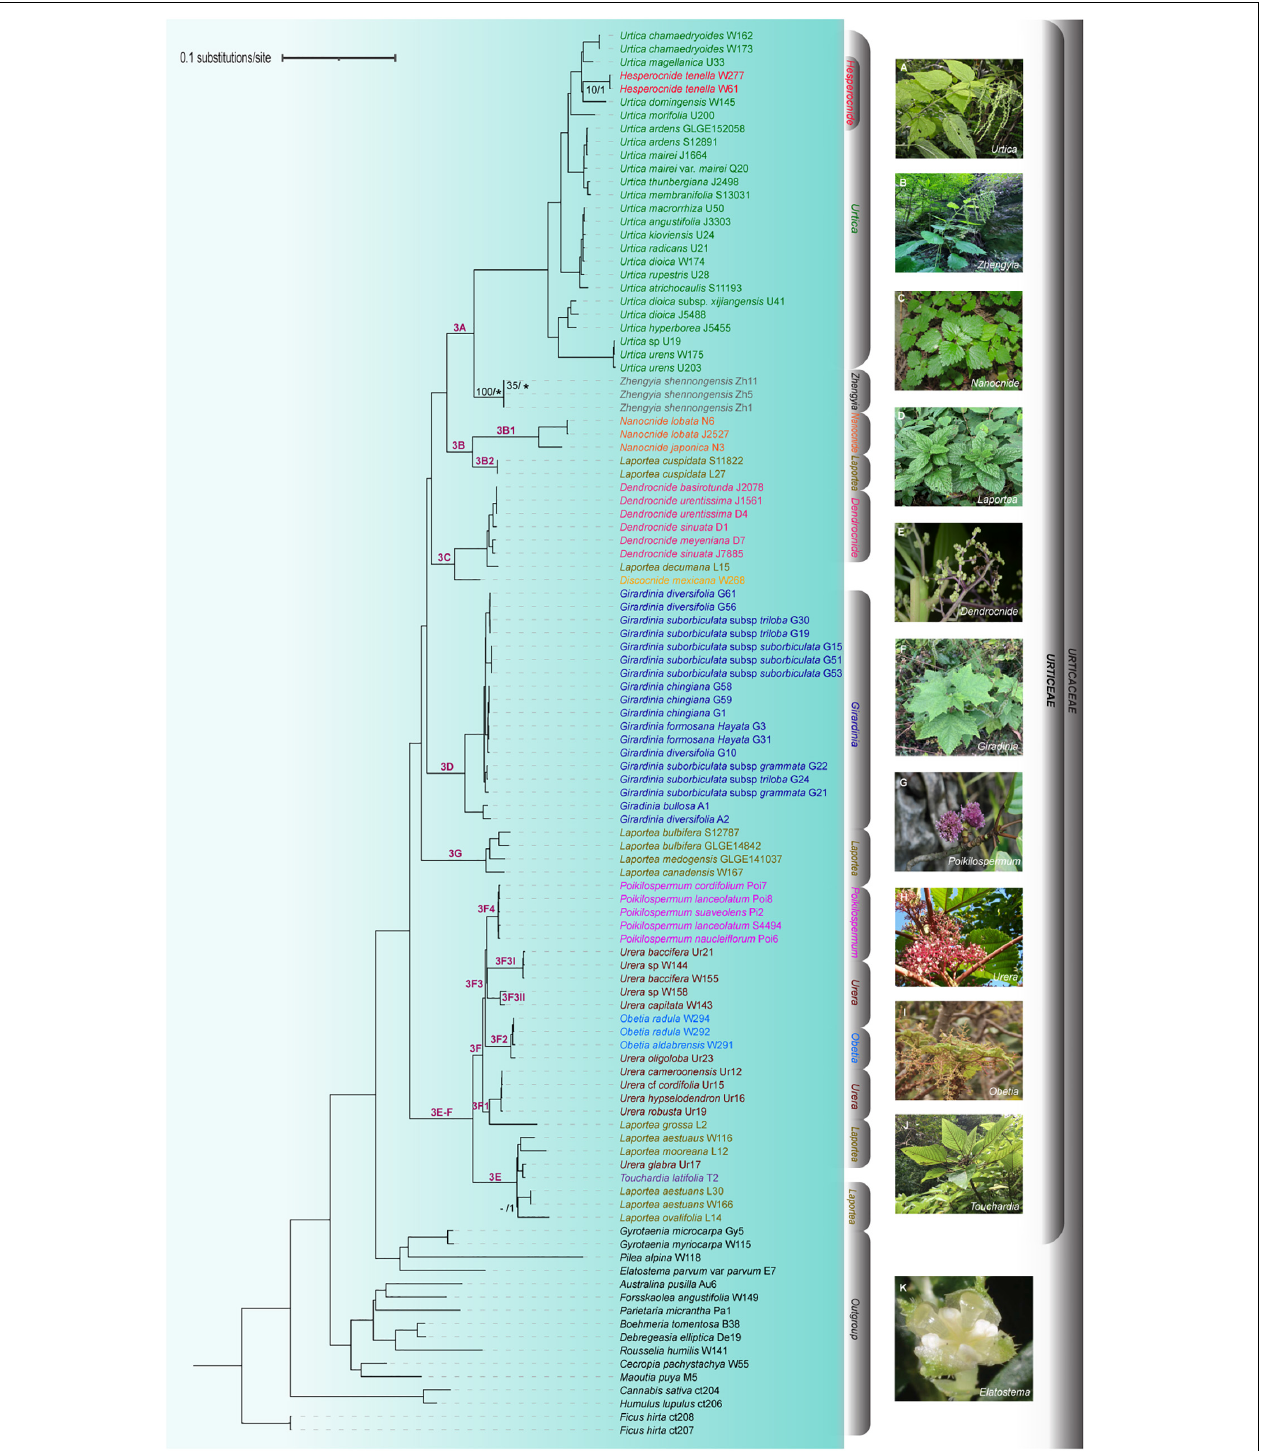
FIGURE 5 | Phylogenetic relationships of Urticeae inferred from maximum likelihood (ML) and Bayesian inference (BI) based on combined complete plastome and nrDNA sequences. Numbers on the branch indicate clade classification (in purple) and ML_BS/BI_PP values (in black)—note that branches with no support values indicate both ML_BS ≥ 90 and BI_PP = 1.00; lastly, “*” indicate incongruence between ML and BI trees and “–” no support values. Representative images of genera within Urticeae s.l. are shown on the right. Photographs: (A–C,E,G,K) by Z.Y. Wu, (D,F) by C.A. Ogoma, (H) by U. Dreschel, (I) by C. Kunath, and (J) photographed by J.